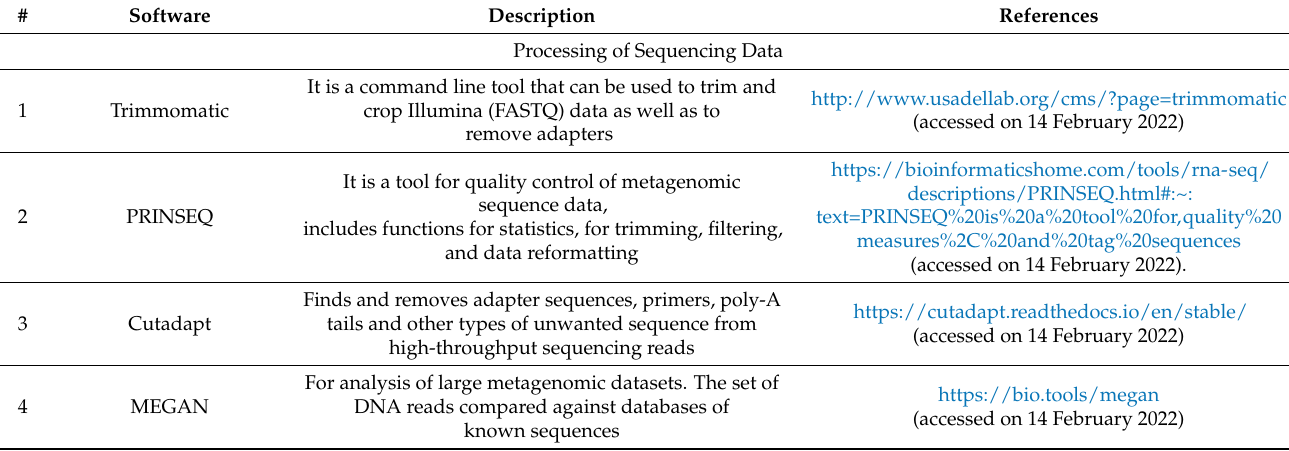
Table 1. List of software for NGS data